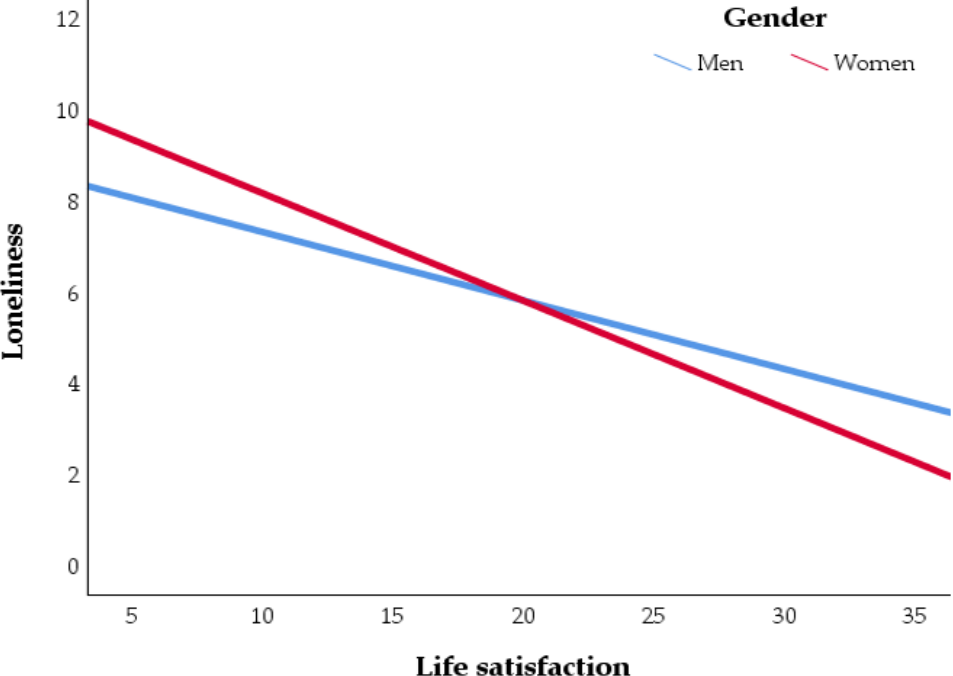
Figure 3. Interaction effect between life satisfaction and gender on